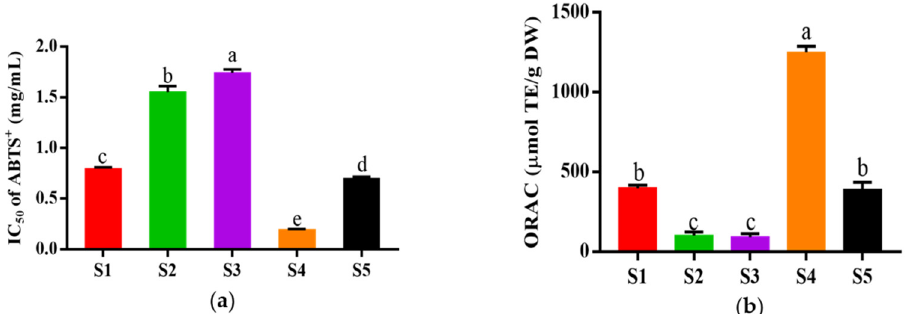
Figure 3. In vitro antioxidant activity of different fractions from HPM-3 separated by Sephadex G-25 gel chromatography: ( a ) IC 50 values of ABTS + assay of five fractions; ( b ) ORAC values of five fractions. Data were expressed as mean ± SD ( n = 3, p < 0.05). Different letters indicate significant differences. ( p < 0.05).